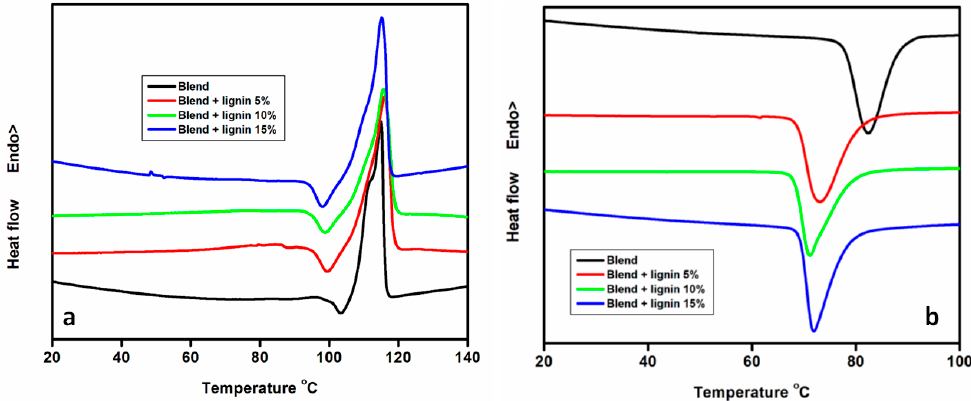
Figure 4. DSC thermograms of the blend and composites after ( a ) heating and ( b ) cooling.